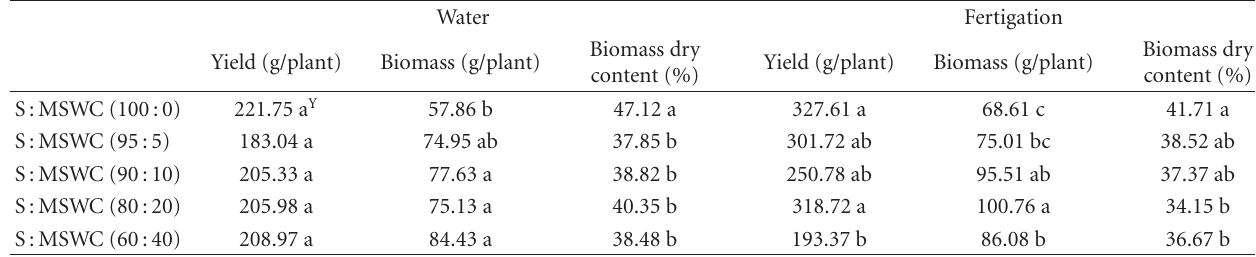
Table 2: E ff ects of municipal solid waste compost (MSWC) into soil (S) with or without fertigation on yield (g/plant), upper biomass fresh fruit (g/plant), and upper biomass dry matter (%) in greenhouse pepper crop.